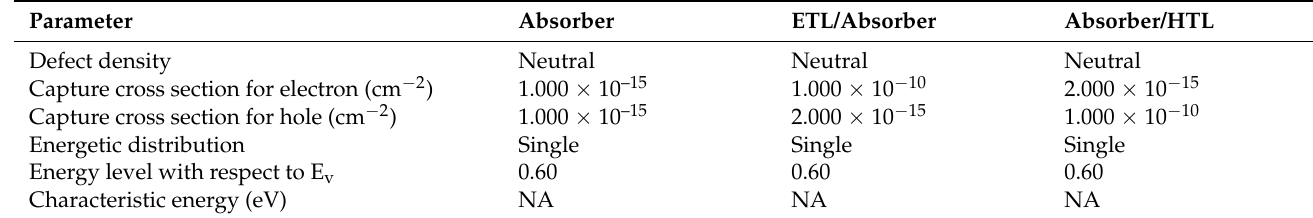
Table 3. Defect density inside the absorber layer and at interface of the